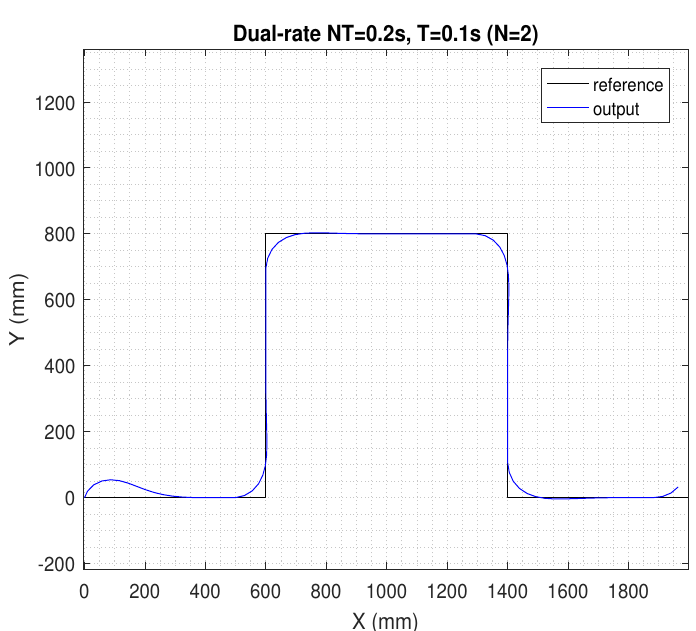
Figure 7. Results for the dual-rate control at NT = 0.2 s and T = 0.1